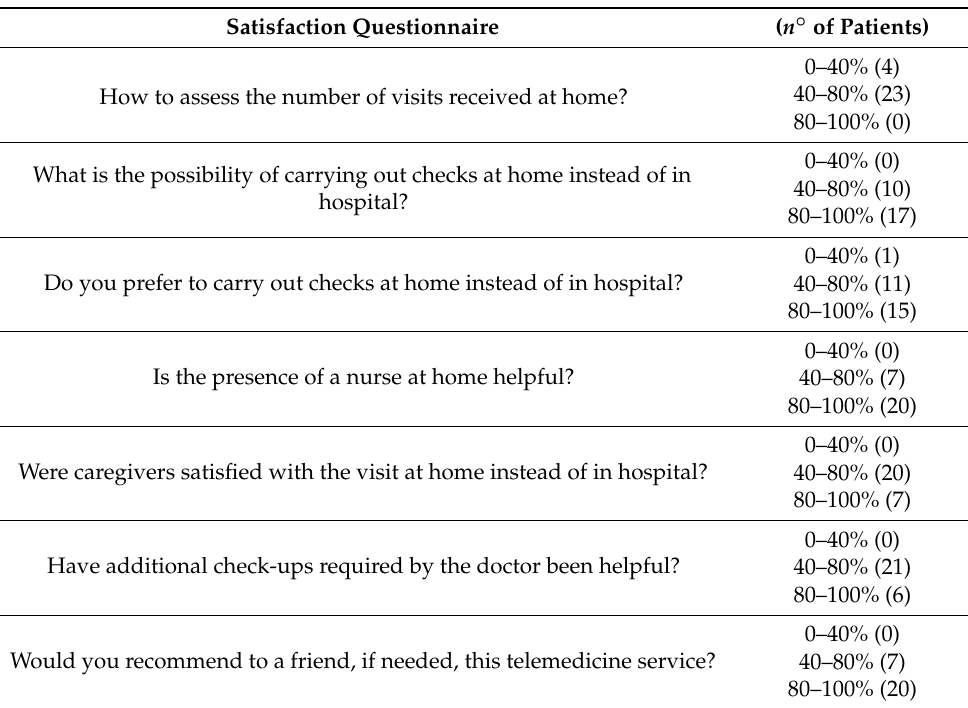
Table 3. Satisfaction questionnaire ( n = 27